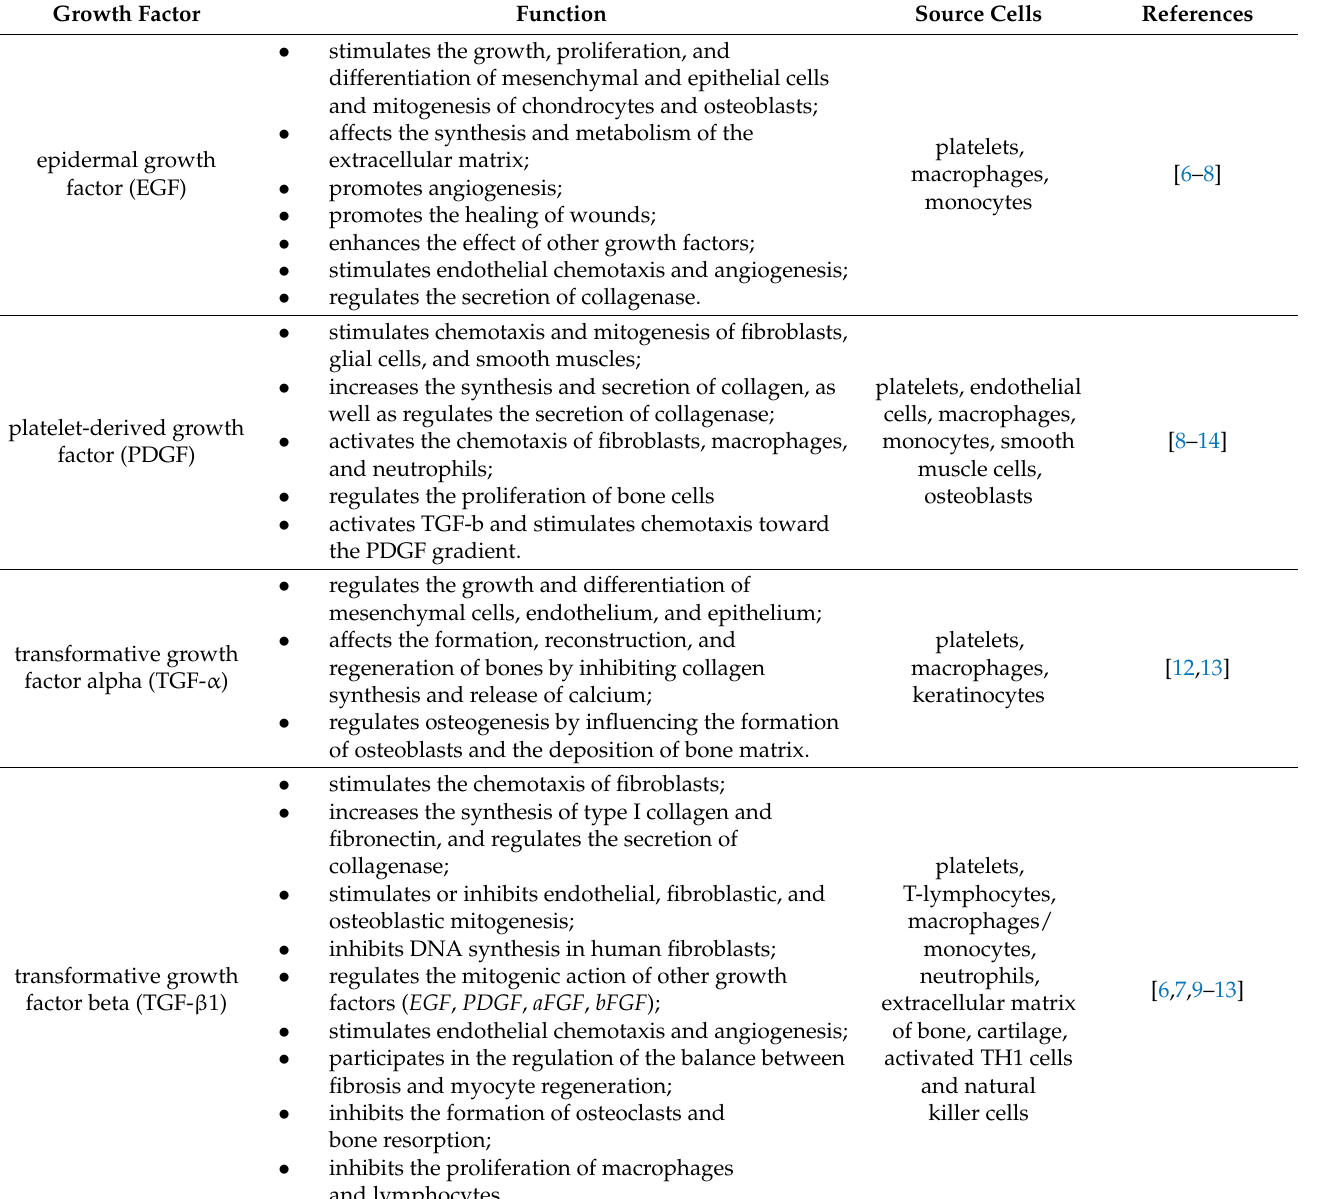
Table 1. Growth factors in platelet and their source and